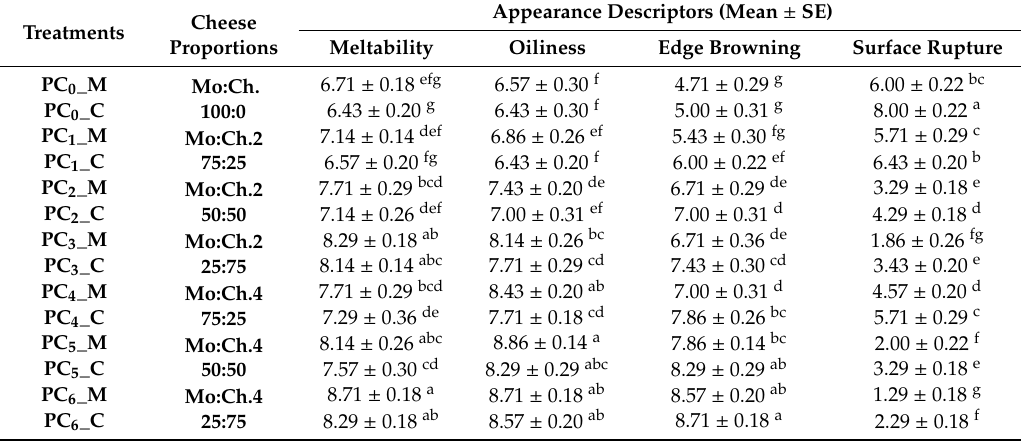
Table 5. E ff ect of proportion of cheeses, ripening time (months) of Cheddar cheese and cooking methods on the appearance descriptors of Pizza cheese. Appearance Descriptors (Mean ± Cheese Treatments Proportions